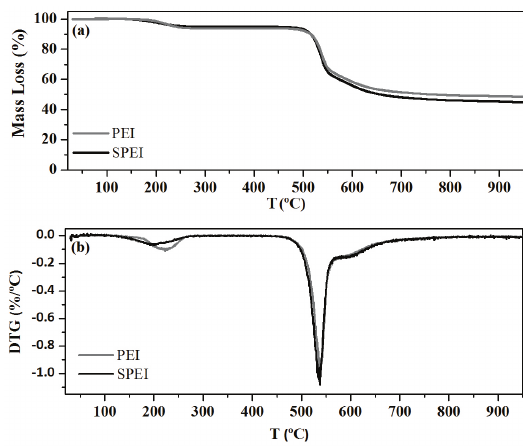
Figure 2. TG (a) and DTG (b) curves of PEI (gray line) and SPEI (black Table 2. Permeabilities measured with pure gases and CO Polymer